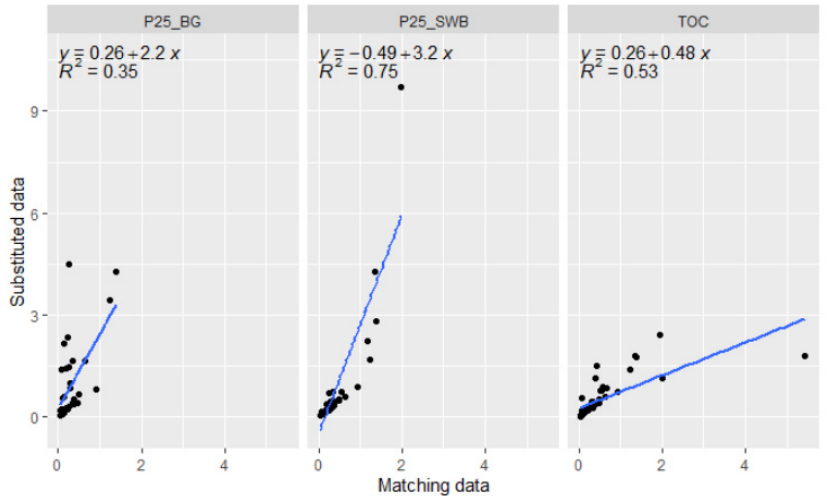
Figure 6. The comparison of the PNEC Pro calculated RCR for Cu between the matching data and substituted data (P25_BG—the 25th percentile of the available DOC data and/or the DOC data calculated by the TOC from the Bulgarian monitoring network results during 2020; P25_SWB—the 25th percentile of the DOC data calculated by the TOC for the respective water body; TOC—the matching DOC data calculated by TOC).